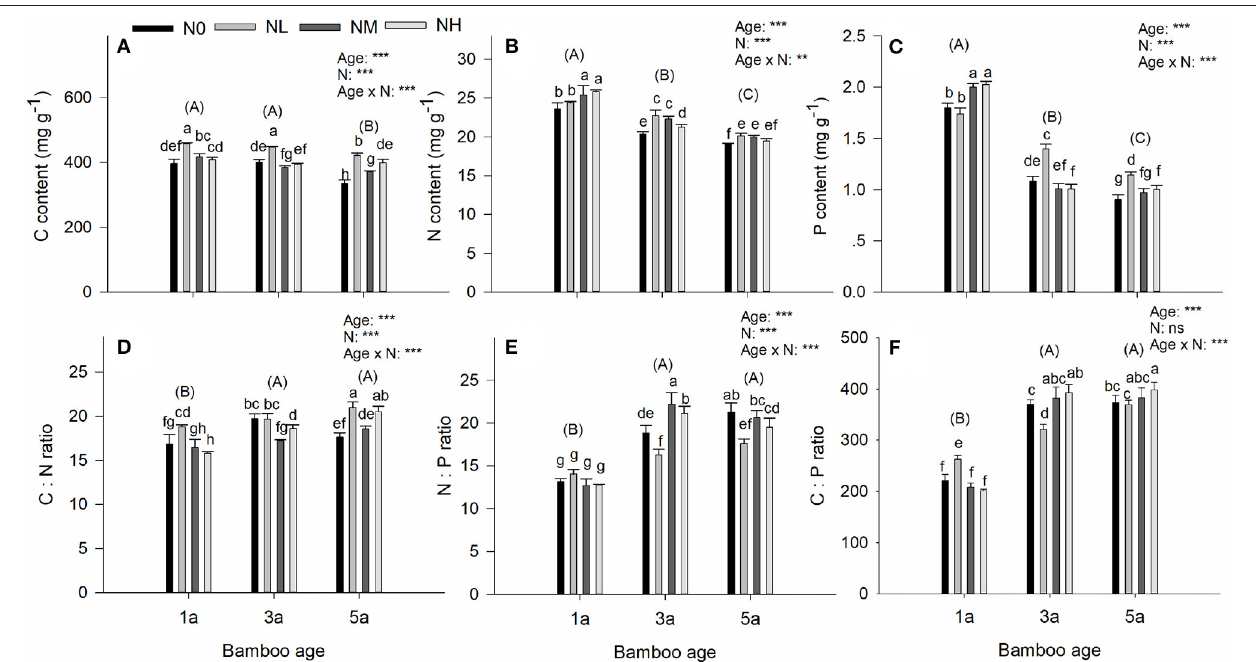
FIGURE 5 | Effects of nitrogen deposition and tree age on foliar stoichiometry in Moso bamboo leaves in a factorial experiment. One-year-old (1a), 3-year-old (3a), and 5-year-old (5a) trees were included in the experiment. Nitrogen deposition treatments: Ambient deposition with no addition (N0, control), low addition (NL = 30kg